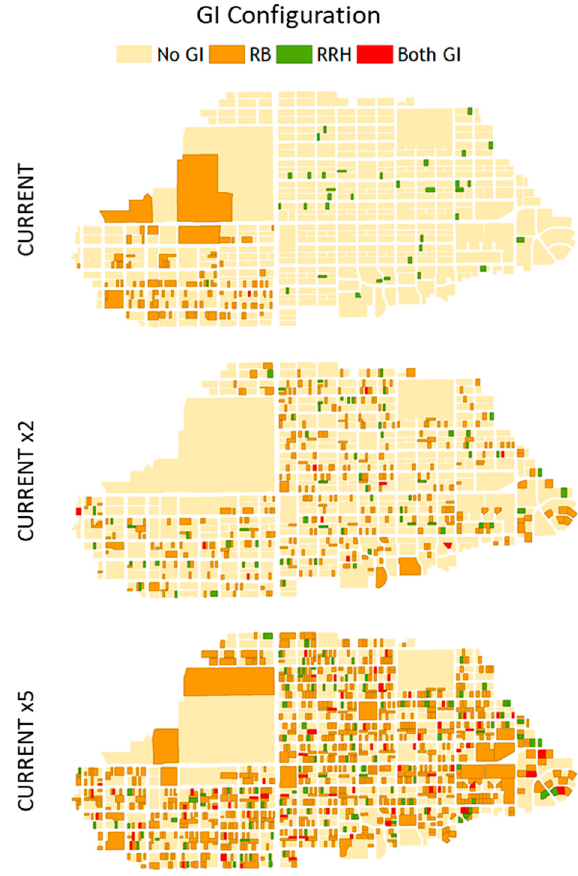
Figure 3. Spatial comparison of the distribution of the GI practices for configurations CURRENT ( top ), CURRENT × 2 ( middle ) and CURRENT × 5 ( bottom ). CURRENT × 2 and CURRENT × 5 configurations represent a hypothetical random distribution of GI practices and only uses basin and cistern sizes from the CURRENT configuration. RB: On-street basins. RRH: Roof runoff harvesting cistern. Table 2. Summary of KINEROS2 model configurations to simulate various GI implementation sce- narios.